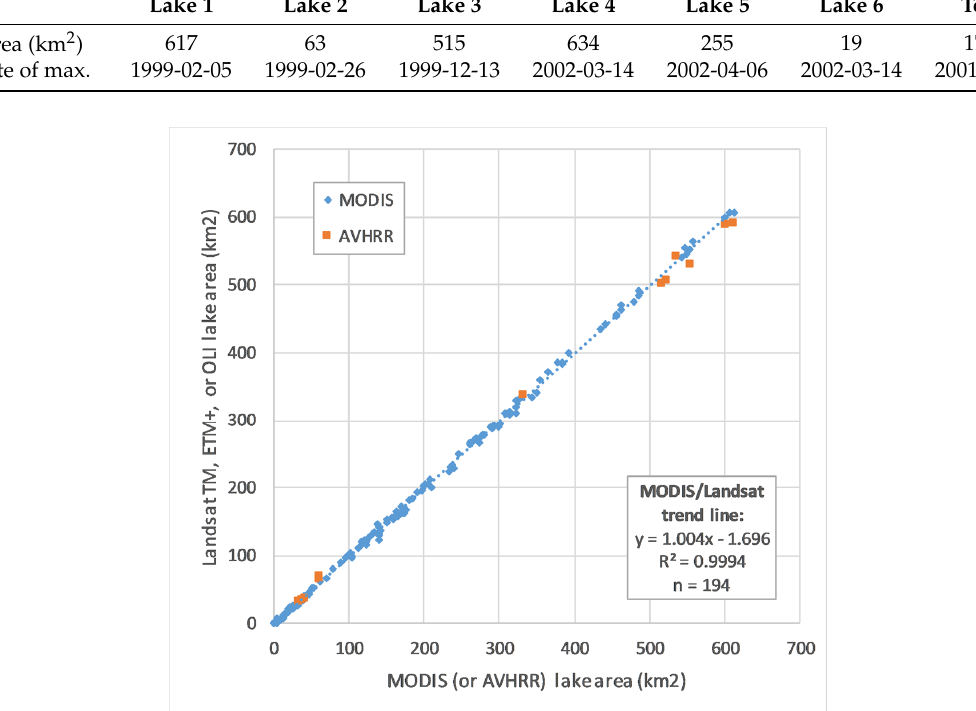
Figure 9. Scatterplot of lake surface area (km 2 ) with coarse-resolution sensor area (MODIS or AVHRR) on the X axis and fine-resolution area (Landsat) on the Y